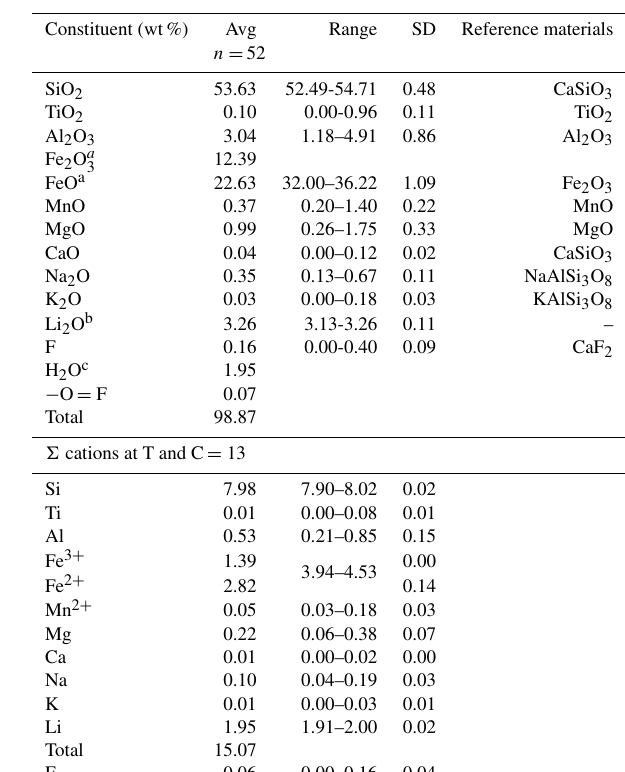
Table 1. Chemical composition of